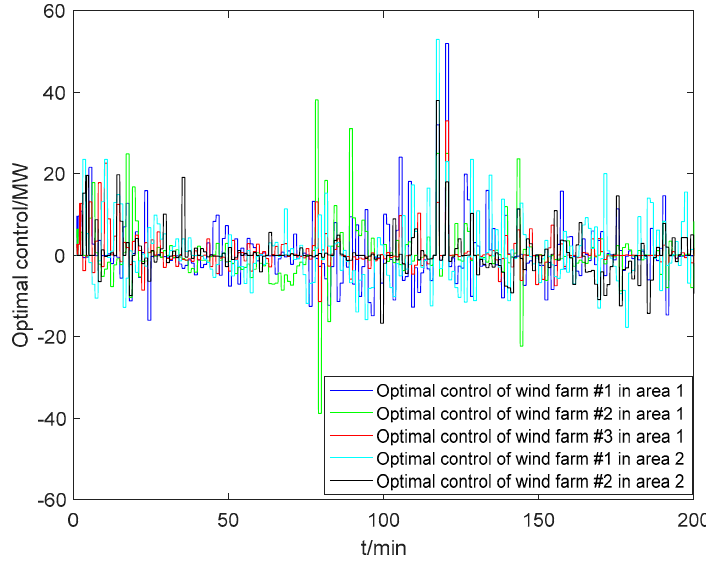
Figure 8. Optimal control applied to each wind farm by DMPC at each time-step.